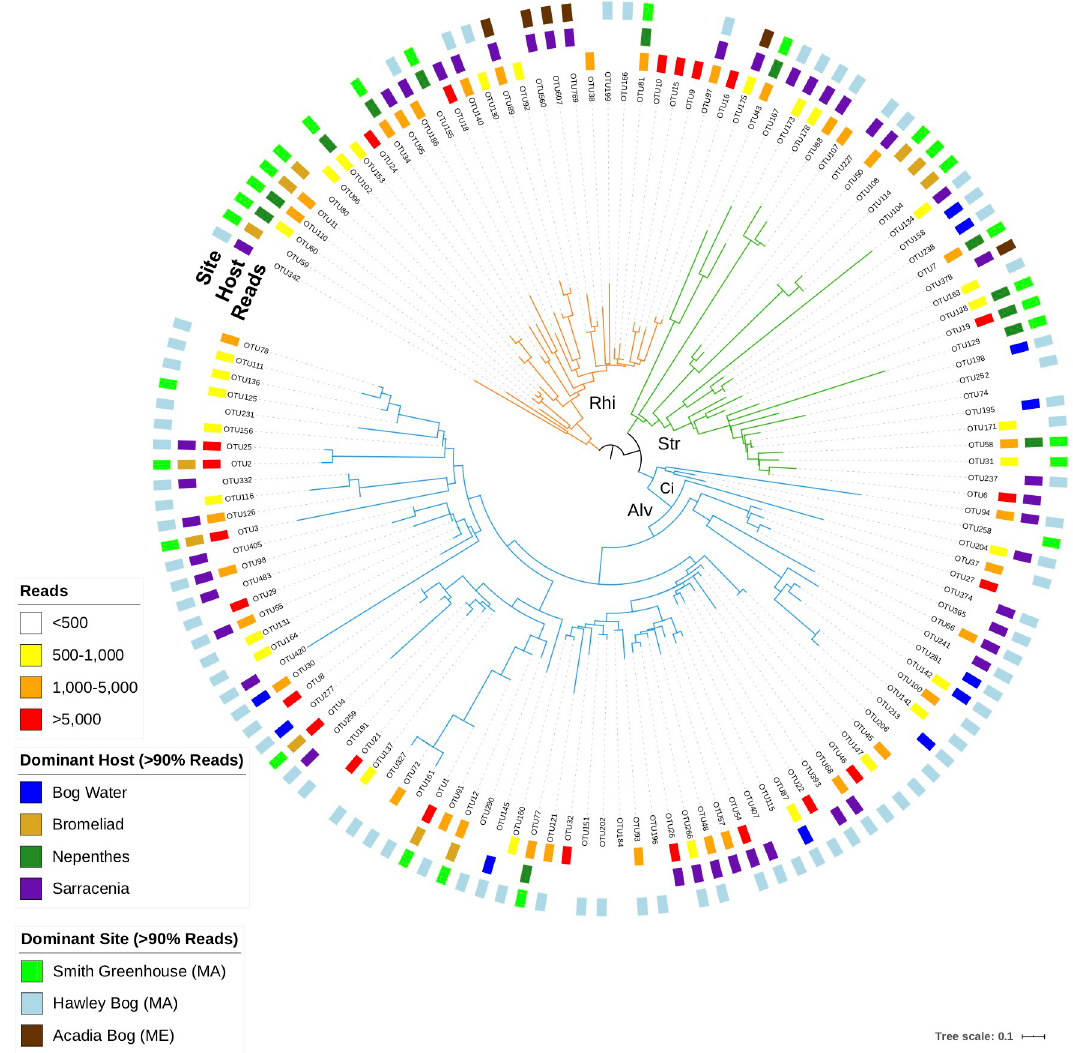
Fig 1. The 135 focal OTUs from across plant hosts and geography illustrate generalist OTUs (i.e. not restricted by plant host or geography) and specialist OTUs (i.e. restricted by plant host or geography). Branches are colored by major clades, Rhizaria (Rhi, orange) Stramenopila (Str, green) and Alveolata (Alv, blue, with Ci indicating ciliates). The number of reads is indicated in the inner ring, followed by host plant specificity ( > 90% of reads from a given host), followed by geographic specificity ( > 90% of reads from a given